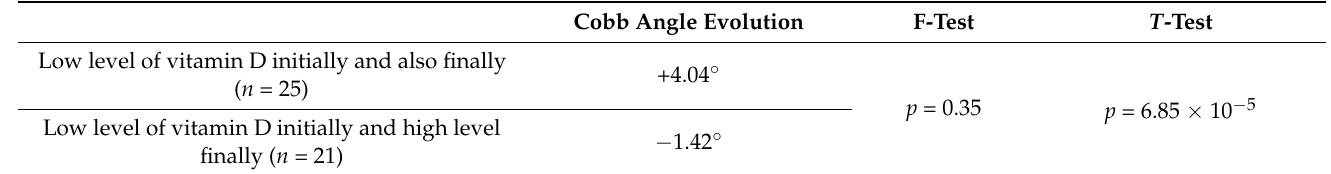
Table 3. Analysis of the Cobb angle evolution for patients who initially had vitamin D3 deficiency grouped by their final serum levels, after one year.